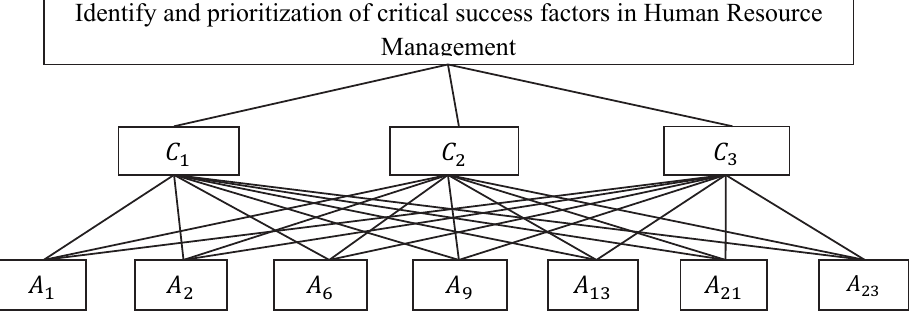
Fig. 2. The decision hierarchy structure in